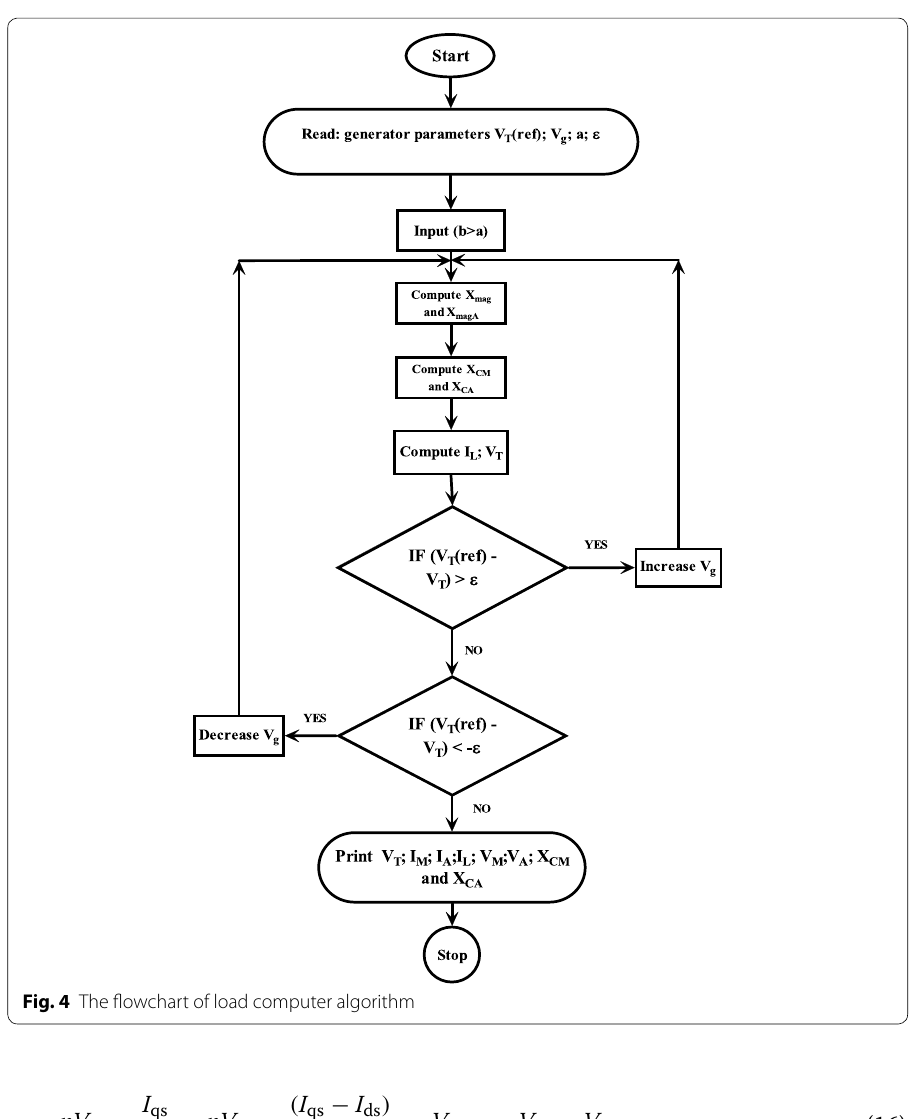
Fig. 4 The flowchart of load computer